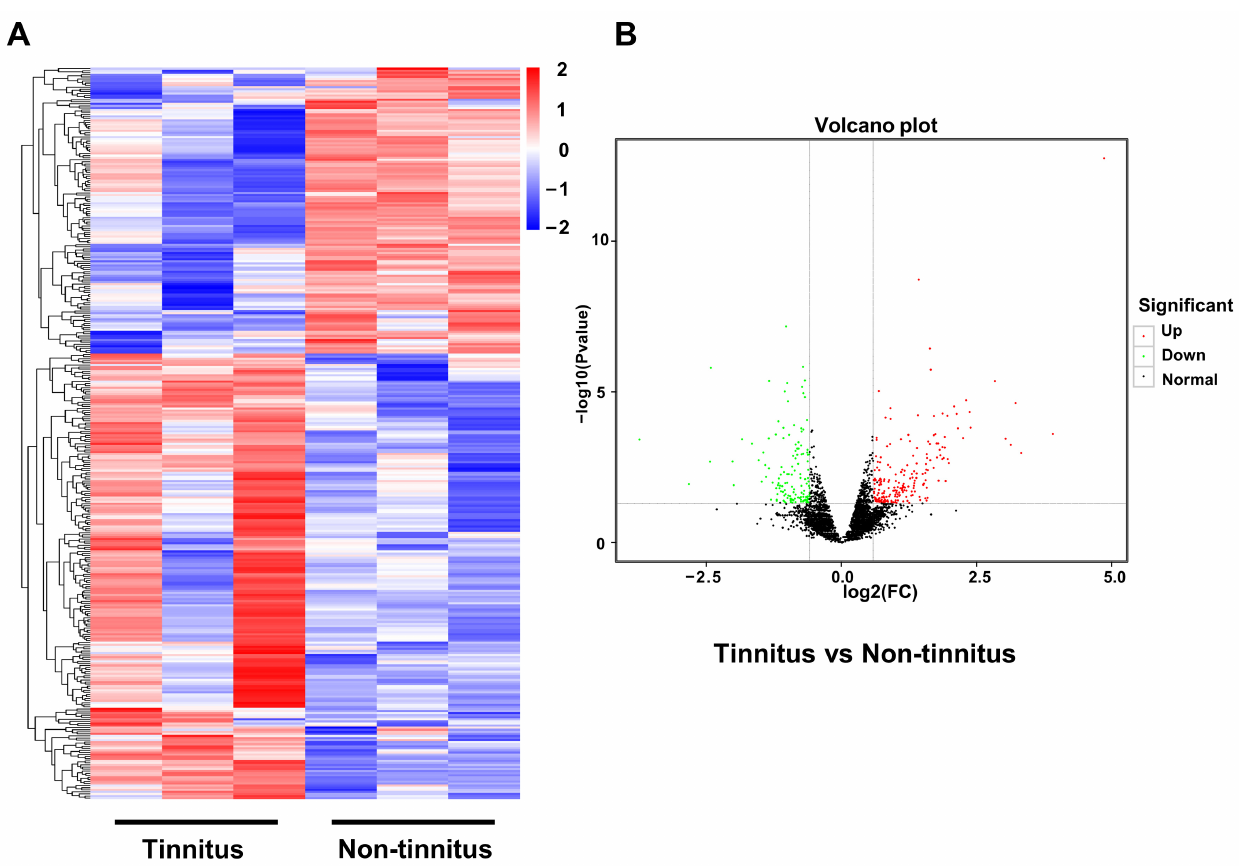
Figure 2. Confirmation of genes differentially expressed in the transcriptional level between the tinnitus and the non-tinnitus group. ( A ) Heatmap of DEGs in the tinnitus ( left ) and the non-tinnitus group ( right ). Blue and red color indicate the down-regulated and up-regulated genes, respectively. ( B ) Volcano image of DEGs between the tinnitus and the non-tinnitus group. The up-regulated genes are displayed in red dots, while the down-regulated genes are shown in green. n = 3. DEGs: differentially expressed genes.